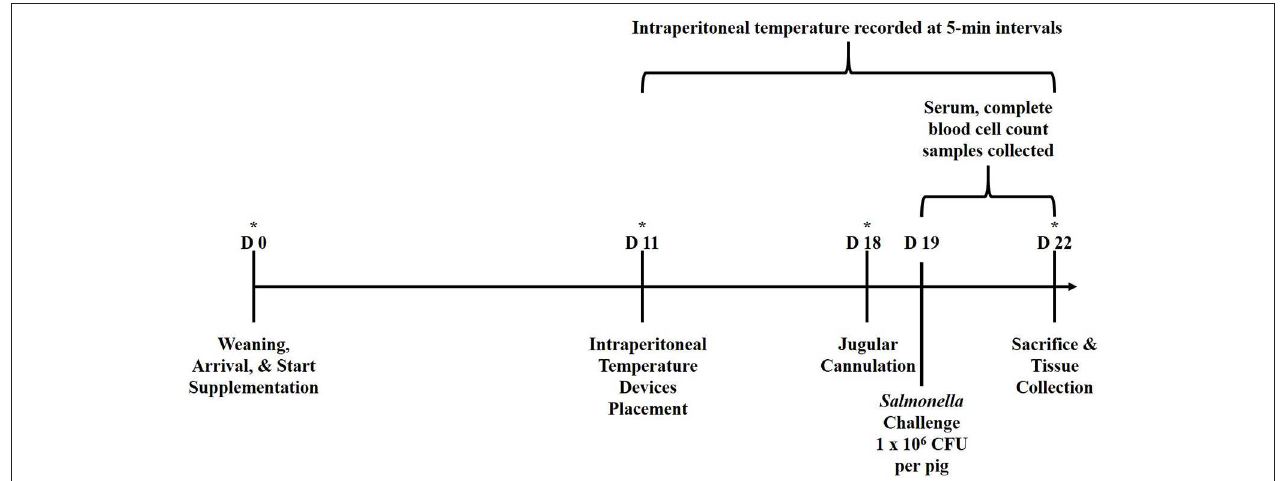
FIGURE 1 | Graphical representation of the study experimental design relative to d of study. Pigs were ∼ 21 d of age at the time of weaning (d 0). *Represents time points in which performance data (pig and feeder weights) were collected. Serum and CBC samples were collected at 6-h intervals from − 6 to 72 h relative to Salmonella challenge at